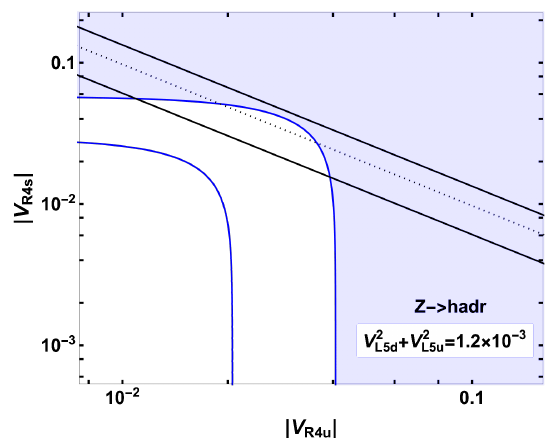
Figure 20 . Excluded area in the | V R 4 u | and | V R 4 s | parameter space. The blue area is excluded by experimental constraints from Z -boson decay rate into hadrons (6.72) using | V L 5 d | 2 + | V L 5 u | 2 = 1 . 2 × 10 − 3 . The blue curve indicates where the bound is shifted if the condition | V L 5 d | 2 + | V L 5 u | 2 = 1 . 78 × 10 − 3 (6.66) is used. The black curve stands for the solution | V ∗ eq.